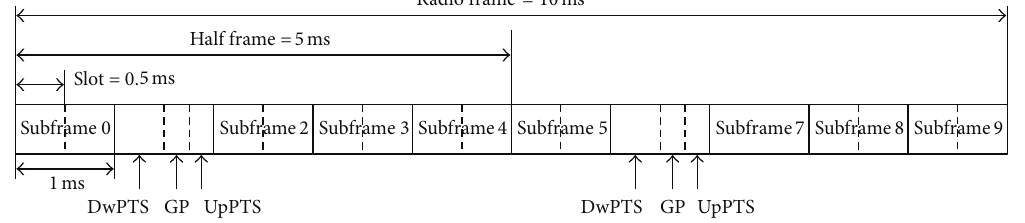
Figure 1: TD-LTE frame structure (5ms periodicity).